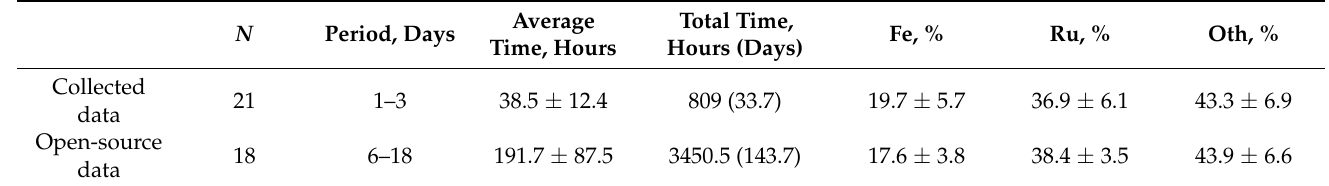
Table 1. Characteristics of datasets used for NN model training (mean ±